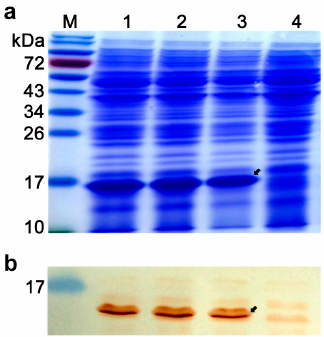
Figure 2. SDS-PAGE ( a ) and western-blot assays ( b ) of cellular lysates of nisin-induced L. lactis strains. Mouse anti- H. pylori sera were obtained by subcutaneous immunization with H. pylori lysates plus Freund’s adjuvant, and used as the primary antibody. 1,2,3, L. lactis NZ3900/pNZ- Δ sp-napA ; 4, cell lysates of NZ3900/pNZ8110. Arrows indicate NapA expression products. Appearance of positive reaction band at approximately16 kDa demonstrated antigenicity of the napA expression product.